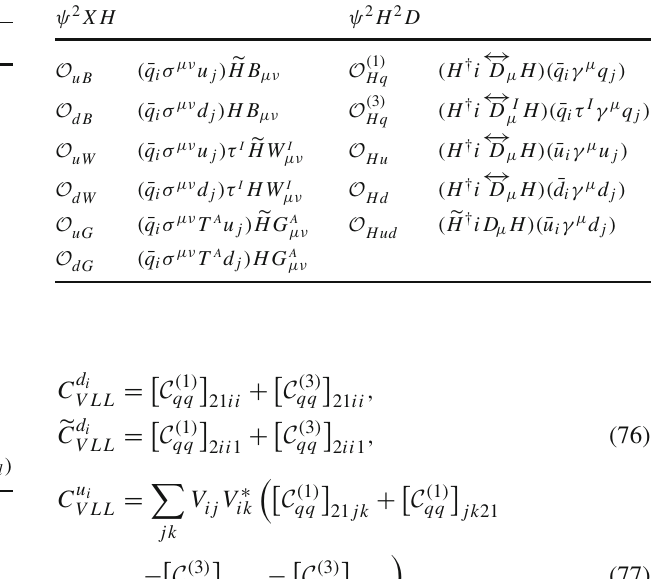
Table 11 List of the dimension-six four-fermion ( ψ 4 ) operators in SMEFT that contribute to s → d transitions at tree level or via mixing. Flavour indices on the quark and lepton fields are ijkl